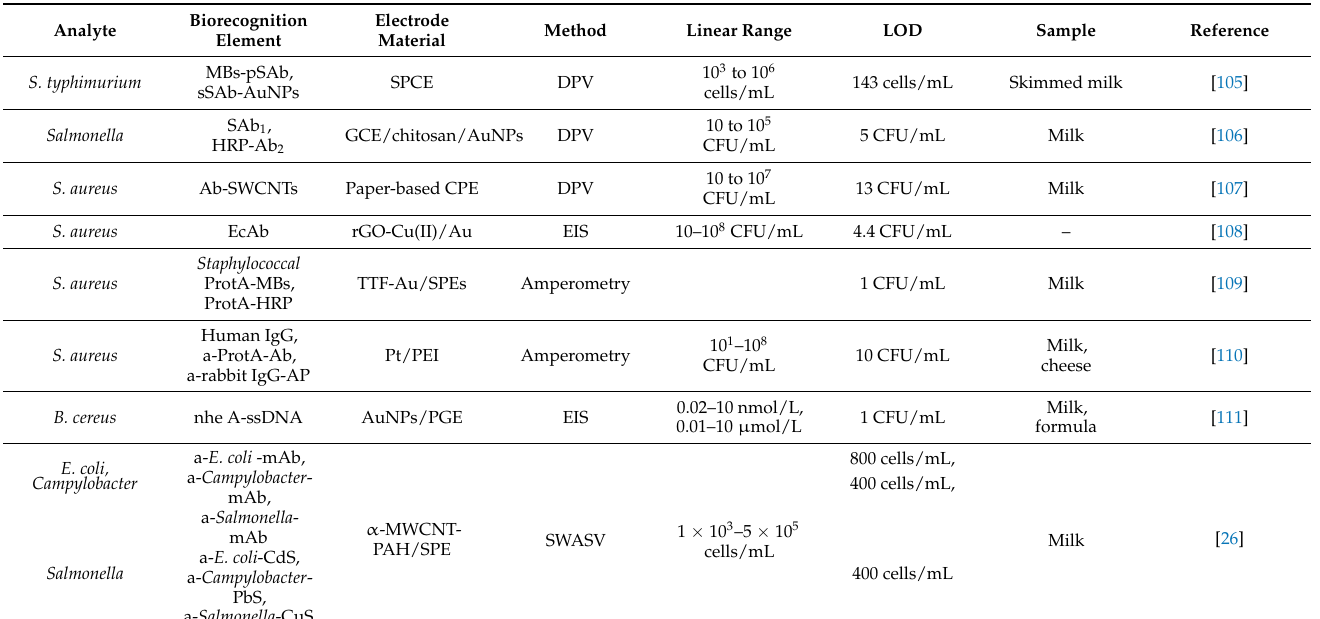
Table 5. Summary of electrochemical biosensors for various foodborne pathogens in milk and milk